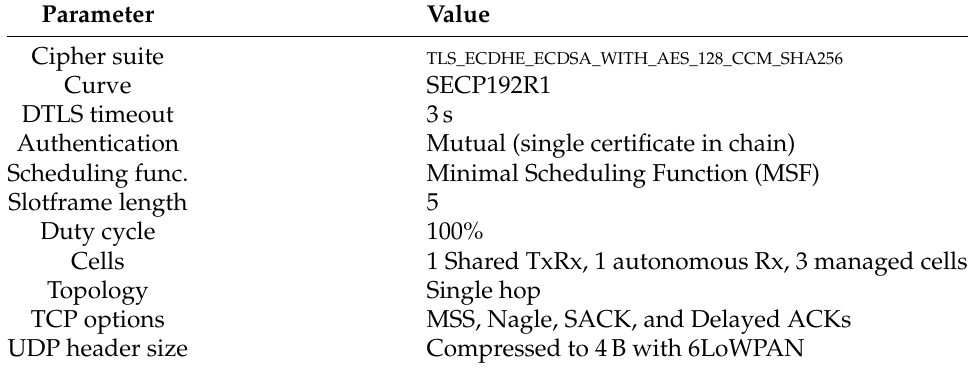
Table 1. 6TiSCH and (D)TLS